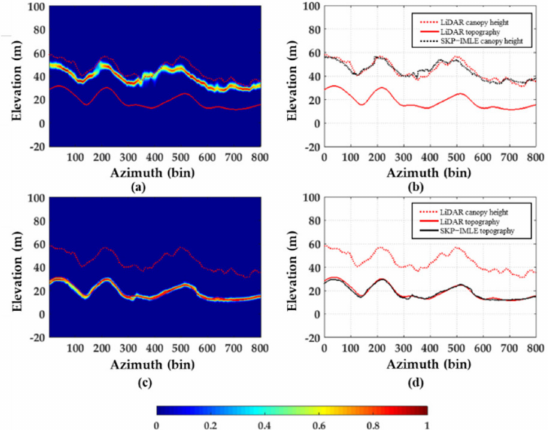
Figure 9. The normalized tomograms of test line1 estimated by SKP-IMLE method and the forest height and underlying topography extracted from the tomograms: ( a ) tomogram of ground scattering; ( b ) estimated forest height of test line1; ( c ) tomogram of ground scattering; ( d ) estimated underlying topography of test line1.